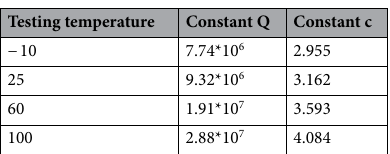
Table 3. The stress life equation constants at different testing temperatures.